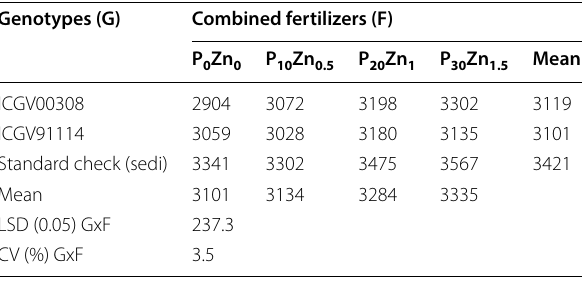
P kg/ha Zn g/L, LSD (0.05) = = CV coefficient of variation =